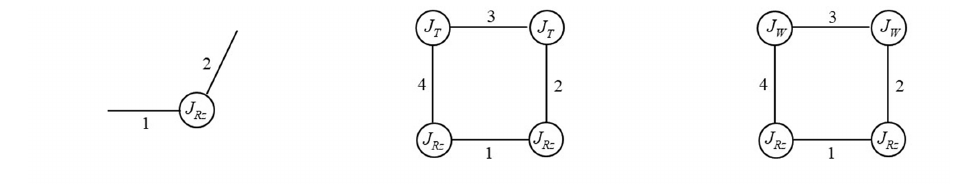
Figure 3. The chains of the cotton gin and hand spinning wheel.